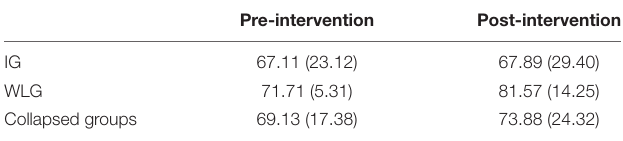
TABLE 3 | Mean (SD) for the pre- and post-intervention Adaptive Behavior Composite (ABC) score Vineland Adaptive Behavior Scales for the IG ( n = 9), the WLG ( n = 7), and the two groups as collapsed ( N = 16).